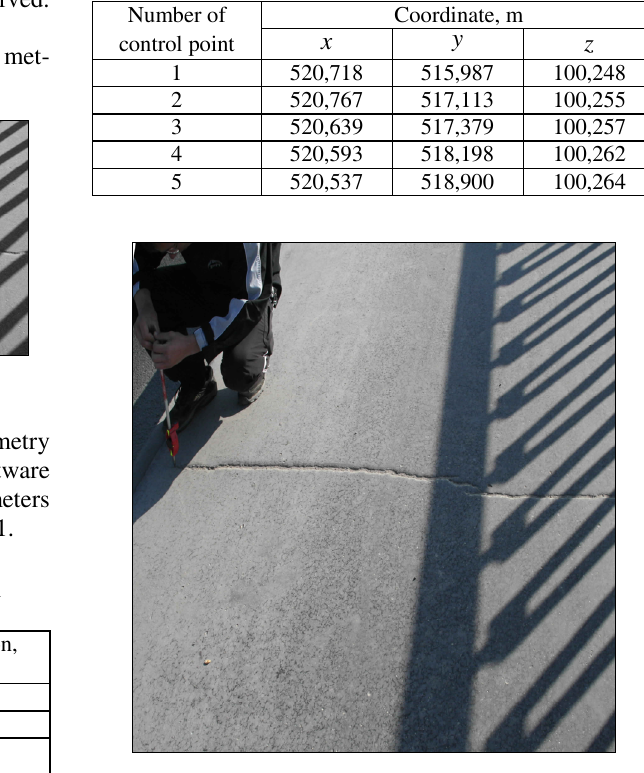
Fig 3. Rectified image Table 3. Images rectification